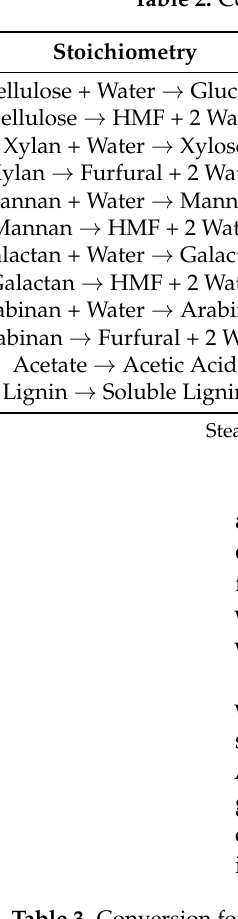
Table 3. Conversion for reaction considered in the neutralization (R2) and in the re-acidification (R3) processes.